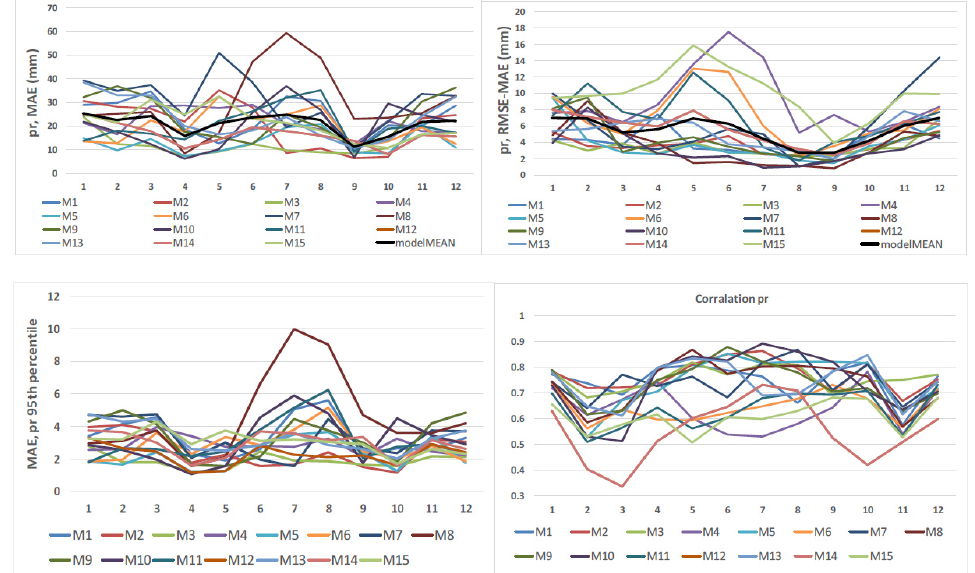
Figure 6. Validation metrics for precipitation, EURO-CORDEX simulations (full names of individual models are given in Table 1) against ROCADA observation-derived data, over the period 1971–2000.